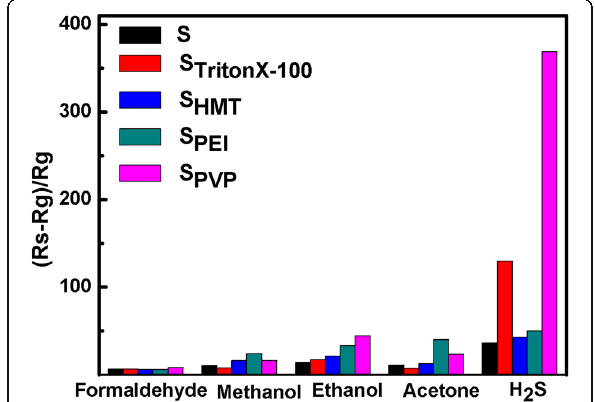
Fig. 8 The comparison among sensor response of SnO 2 nanomaterials to 100 ppm of various gases at the optimal operating